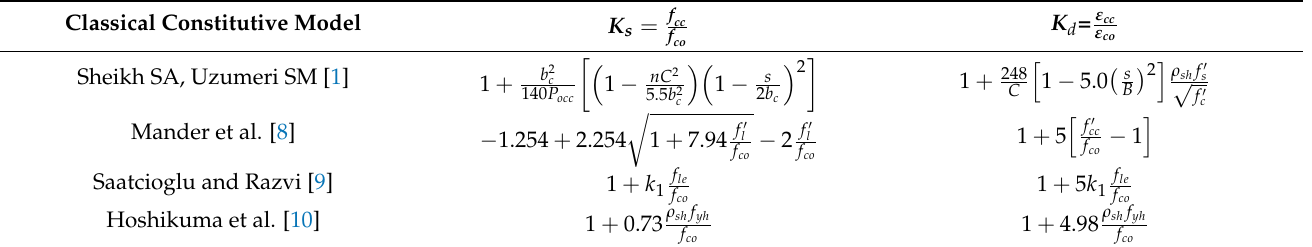
Table 1. Peak stress/strain factor of SRC column.